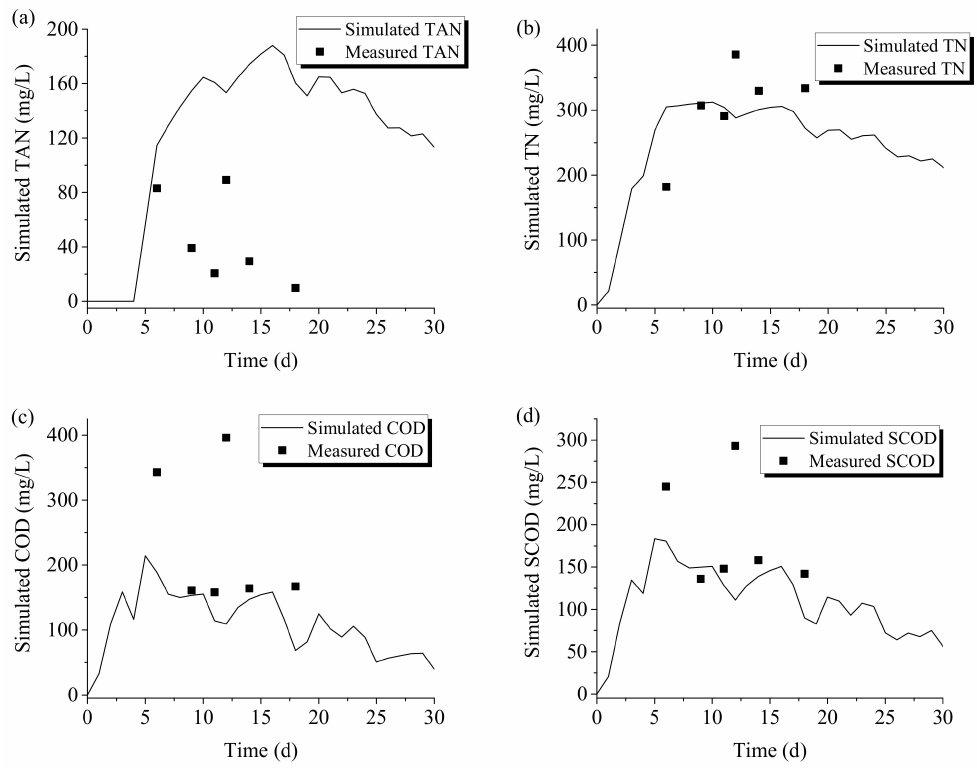
Figure 8. Simulated and measured values of ( a ) TAN, ( b ) TN, ( c ) COD and ( d ) SCOD in the soil layer of 30 cm. Note: TAN—Total ammonia nitrogen; TN—Total nitrogen; COD—Chemical oxygen demand; SCOD—Soluble chemical oxygen demand.